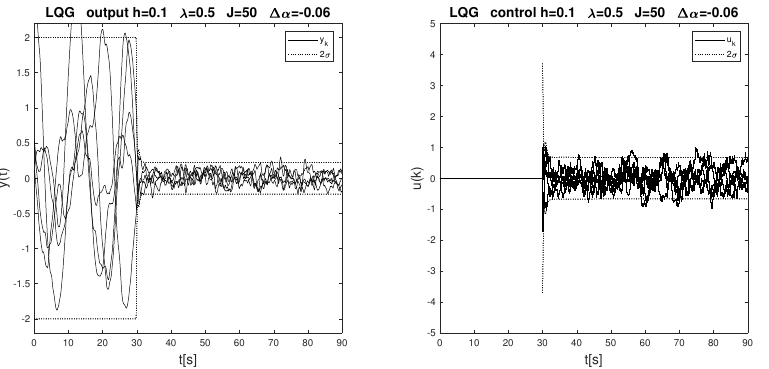
Figure 14. Realization of the output ( left ) and control ( right ) signal for λ = 0.5 and ∆ α =